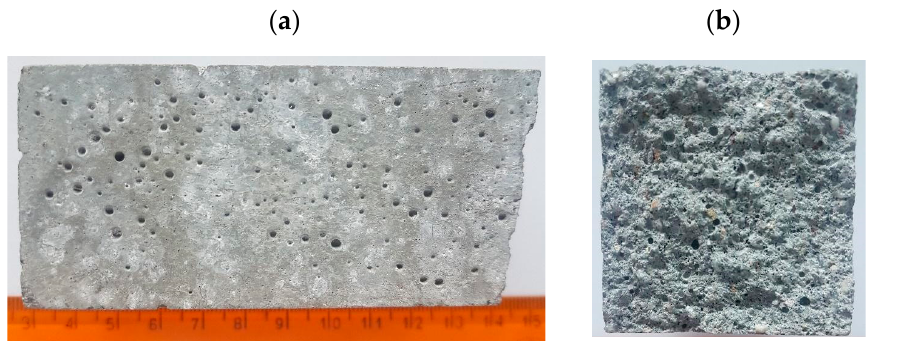
Figure 4. Cement mortar with the addition of 4% fly ash from the incineration plant (CEM I + 4% FA): ( a ) outer surface; ( b ) internal structural view.